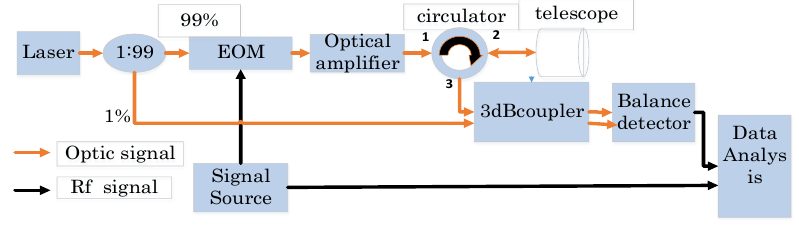
Figure 1 . Block diagram of the system. Figure 1. Block diagram of the